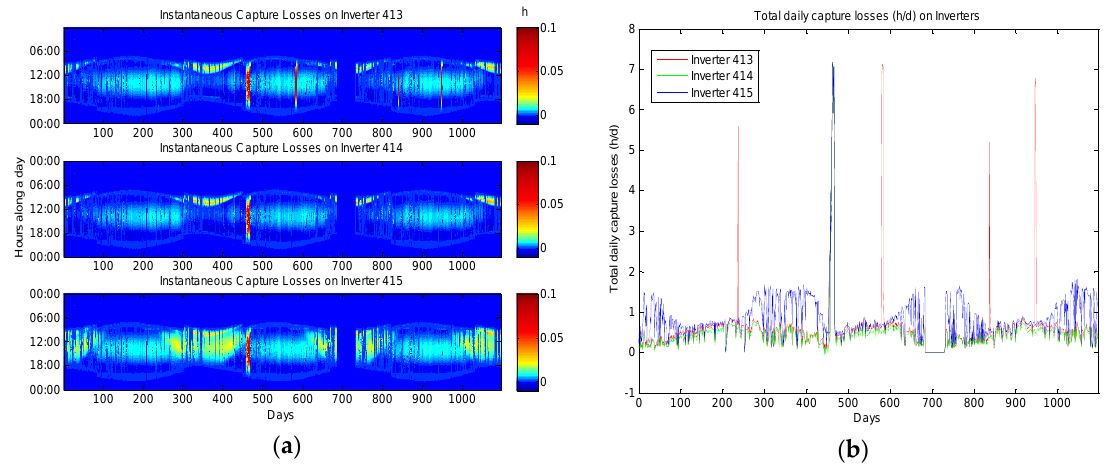
Figure 13. Capture losses from 1 January 2011 to 31 December 2013: ( a ) instantaneous values, during 24 h a day; and ( b ) total daily values.